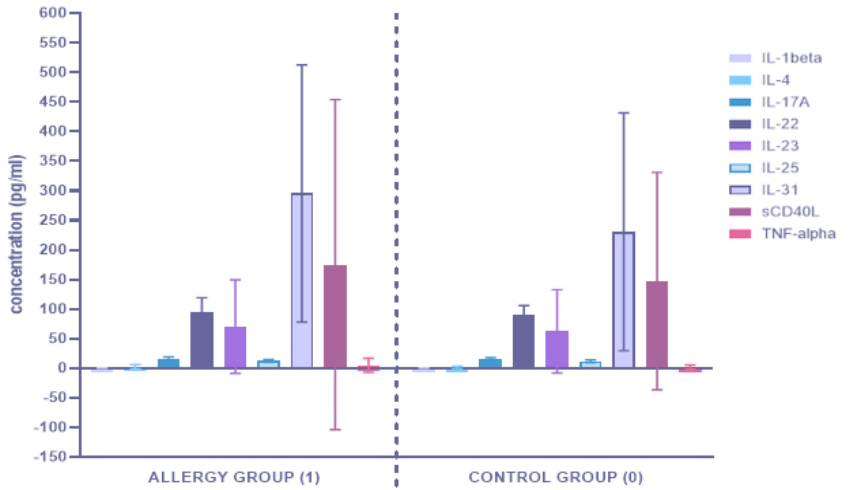
Figure 2. Comparison of serum cytokine concentrations between the allergy group (1) and the control group (0).